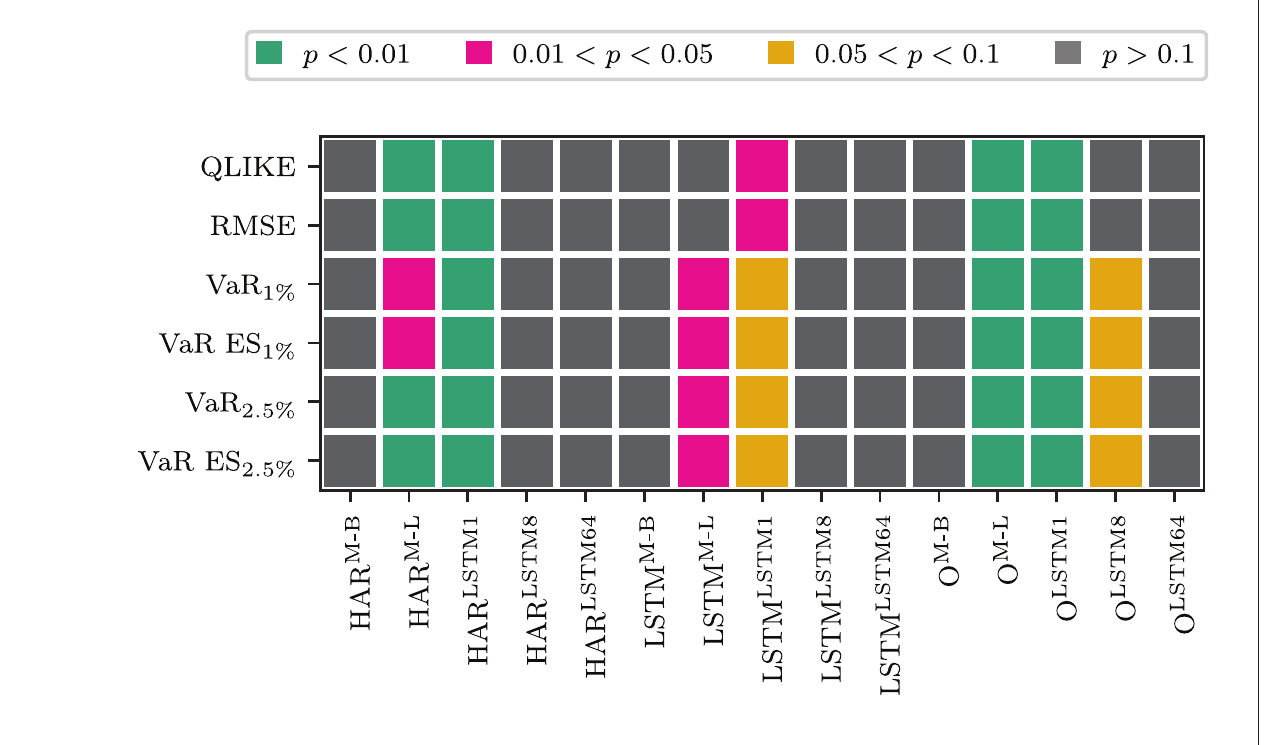
y t ) and the recent information ( ˜